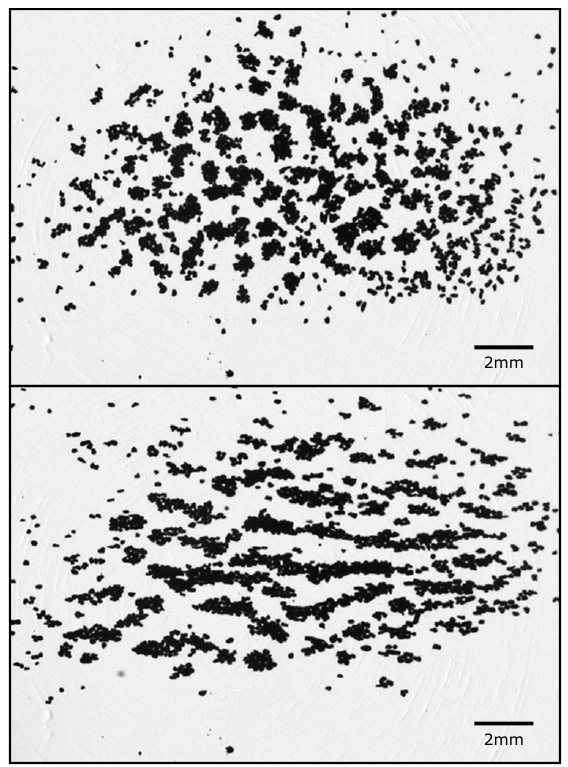
Figure 10. Formation of an elongated cluster of aggregates after applying a magnetic field of 7 mT (from Kruss and Wurm